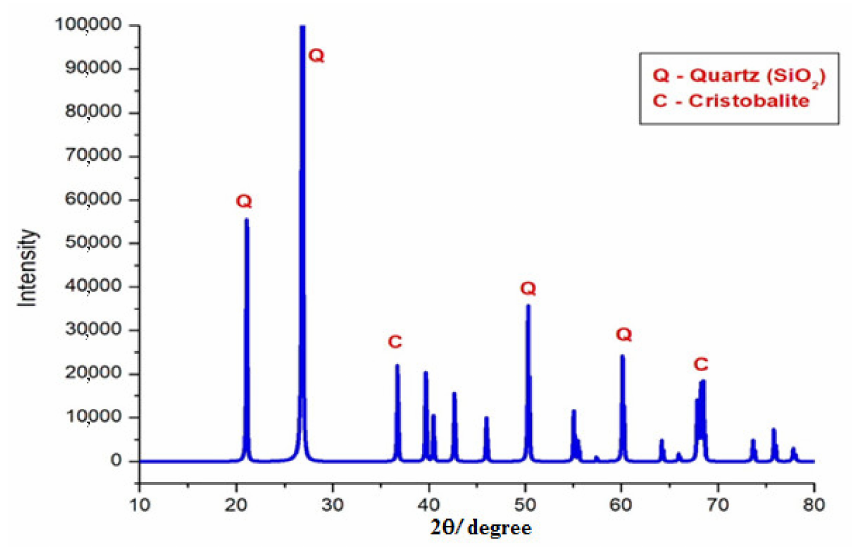
Figure 2. XRD pattern of silica fume.